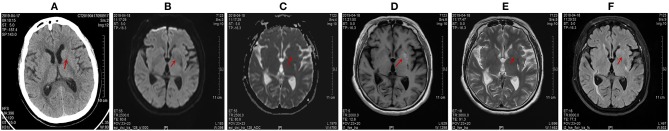
Computed tomography (CT) scans the brain on April 17, 2019 and magnetic resonance imaging (MRI) images of the brain on April 18, 2019. Abnormal signals were marked by red arrow. (A) The disappearance of the high signal intensity in the left lentiform nucleus on CT scans. The CT value of the abnormal lesion center was 32 Hu. (B,C) The left lentiform nucleus showed an equal signal intensity on DWI and ADC scans. The ADC value of the abnormal lesion center was 0.846 * 10−3 mm2/s. (D) The lighter and narrowed signal intensity of the left lentiform nucleus on T1-weighted images. The abnormal signal range of the left lentiform nucleus was narrowed to 8 mm * 4 mm. (E,F) The disappearance of the original high signal intensity on T2-weighted and T2-FLAIR images.